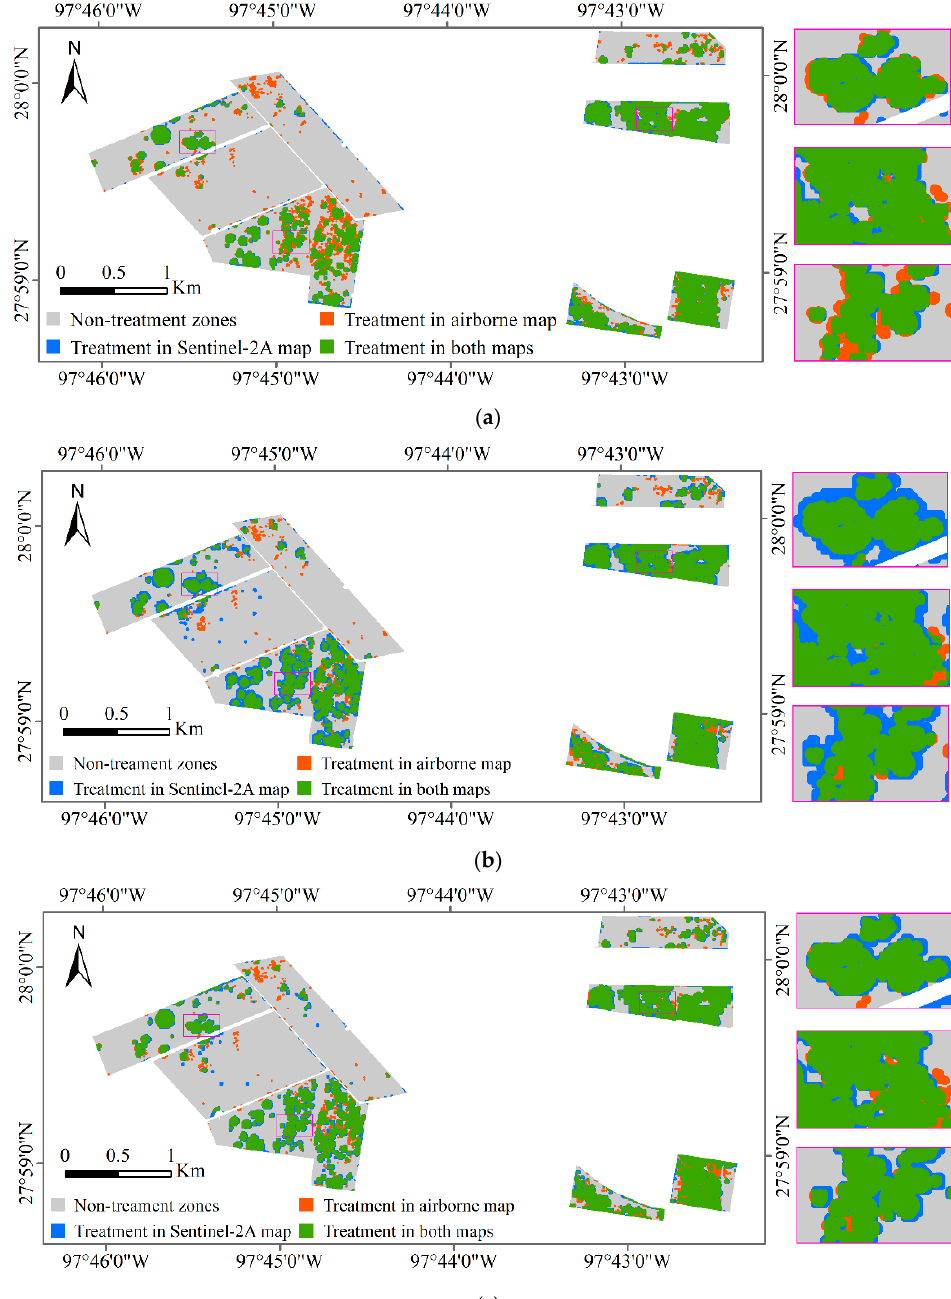
Figure 8. Overlaid prescription maps from airborne and Sentinel-2A images for Fields 1–8 and the zoomed in rectangle scenes for the areas marked on the maps are shown at the right. ( a ) Sentinel-2A prescription map based on the spectral model; ( b ) Sentinel-2A prescription map based on the texture model; ( c ) Sentinel-2A prescription map based on the spectral-texture model.